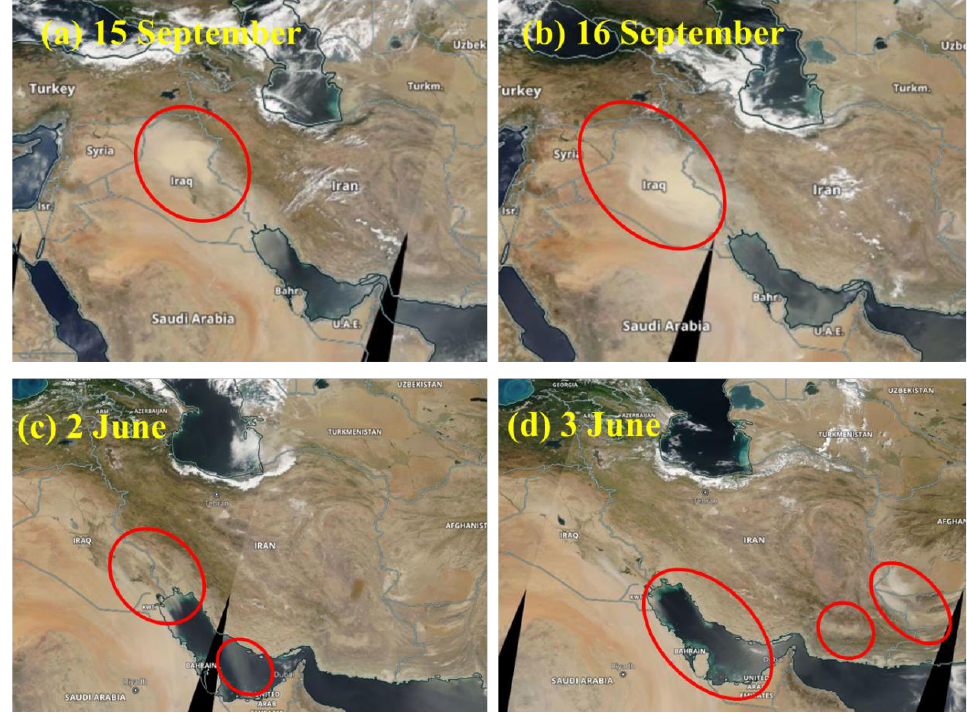
Figure 8. Terra/MODIS true color imagery on ( a ) 15 September 2008, ( b ) 16 September 2008, ( c ) 2 June 2012, ( d ) 3 June 2012.